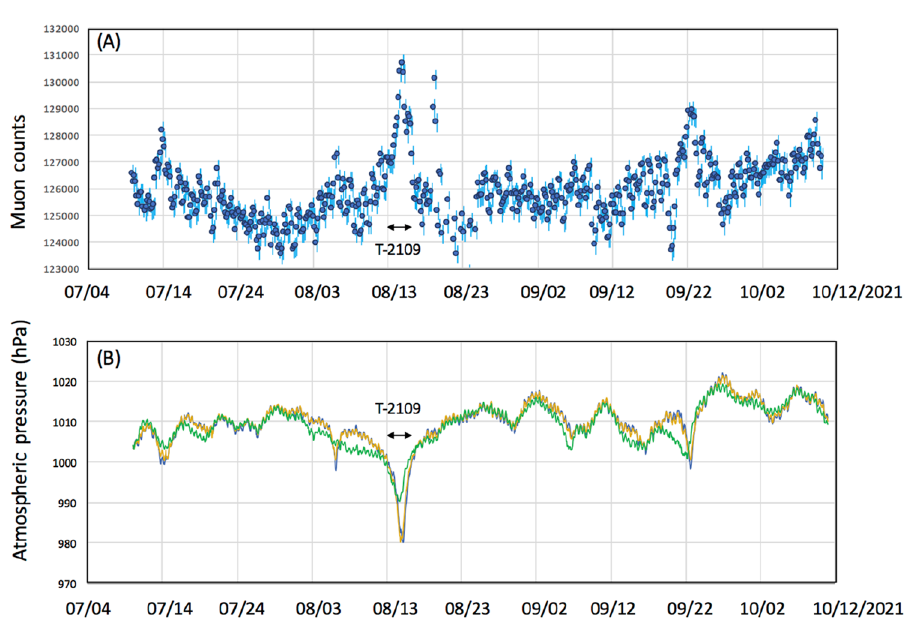
Figure 8. Observed time-dependent variations of the muon count rate in the 2021 typhoon season ( A ). The atmospheric pressure values observed at three BP monitoring stations: Kagoshima (blue), Yakushima (Orange) and Naze (Green) 48 are shown ( B ). The vertical bars associated with the data points indicate 1σ error bars. Arrows indicate the period that T2109